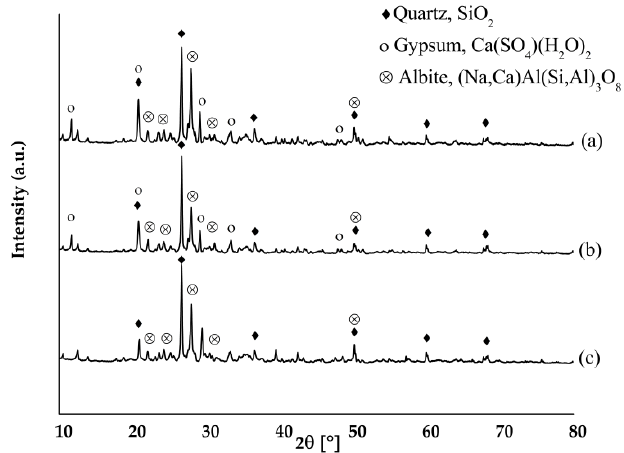
Figure 6. XRD pattern of leaching residues ( a ) with weak acid and ( b ) without weak acid, and of ( c ) copper ore.